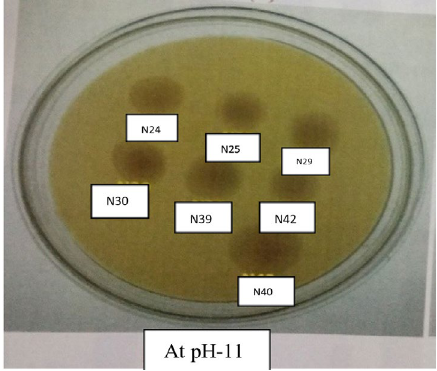
Fig. 1. Nodulation by Rhizobium leguminosarum bv . viciae strain N40 at 45°C on pea plant